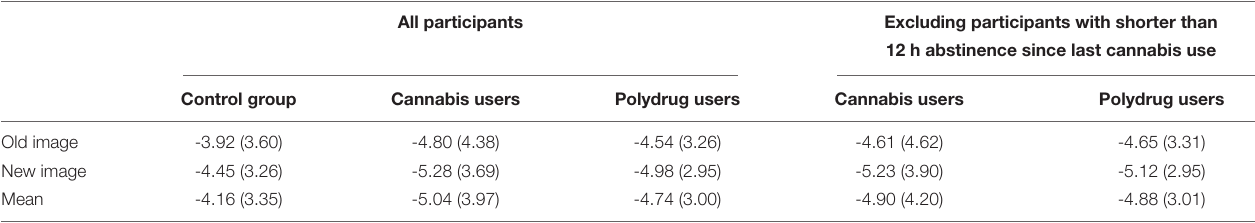
TABLE 5 | Means and standard deviations of the mean amplitudes ( µ V) of the Late Positive Components for all groups and conditions. All participants Excluding participants with shorter than 12 h abstinence since last cannabis use Control